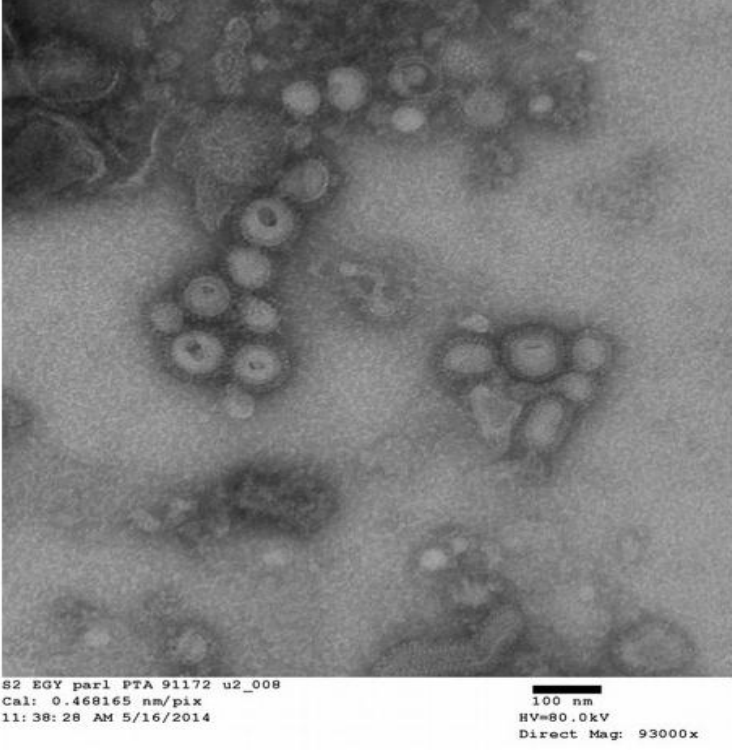
Figure 1. Negative stain transmission electron microscopy. For electron microscopy, VLPs were stained with 1% phosphotungstic acid showing the spherical influenza-like enveloped particles (VLPs).